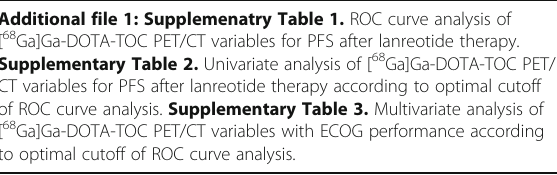
Supplementary Table 2. Univariate analysis of [ 68 Ga]Ga-DOTA-TOC PET/ CT variables for PFS after lanreotide therapy according to optimal cutoff of ROC curve analysis. Supplementary Table 3. Multivariate analysis of [ 68 Ga]Ga-DOTA-TOC PET/CT variables with ECOG performance according to optimal cutoff of ROC curve analysis.